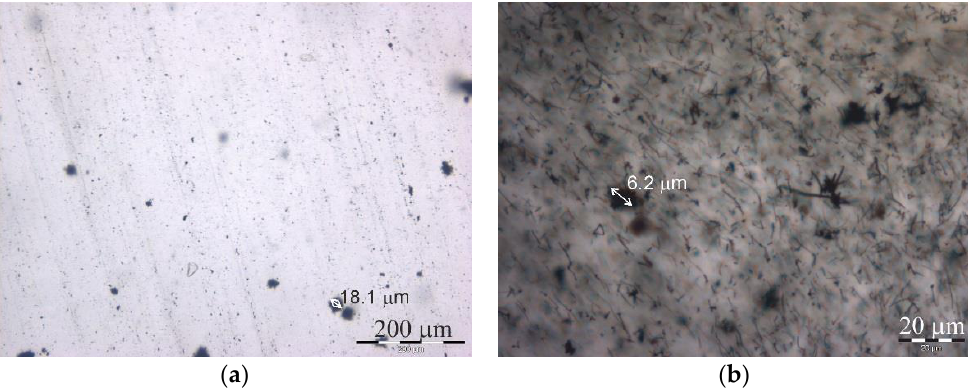
Figure 1. Optical micrographs of the epoxy filled with multiwall carbon nanotubes (MWCNT) contents of 0.005 wt % for N ( a ) and 1 wt % for SA ( b ).